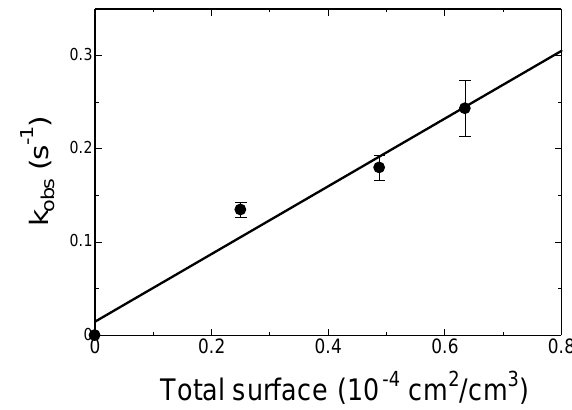
Fig. 2. Dependence of injector position ( l ) on HO 2 signals, at at- mospheric pressure, using the T1 sample from Mt. Tai. Signal in- Figure 2. Dependence of injector position ( l ) on HO 2 signals, at atmospheric pressure, using the T1 3 tensities are normalized against those at the initial injection position sample from Mt. Tai. Signal intensities are normalized against those at the initial injection position 4 ( l 0 ∼ 30cm). The filled circles indicate losses of HO 2 in the absence ( l 0 ~ 30 cm). The filled circles indicate losses of HO 2 in the absence of aerosol particles. The open 5 of aerosol particles. The open circles correspond to HO 2 profiles in circles correspond to HO 2 profiles in the presence of aerosol particles, and the total surface 6 the presence of aerosol particles, and the total surface concentration concentration in this experiment was 0.49 × 10 -4 cm 2 cm -3 at 75% RH. The fitting lines are 7 in this experiment was 0.49 × 10 − 4 cm 2 cm − 3 at 75% RH. The fit- exponential decay fits. 8 ting lines are exponential decay fits.